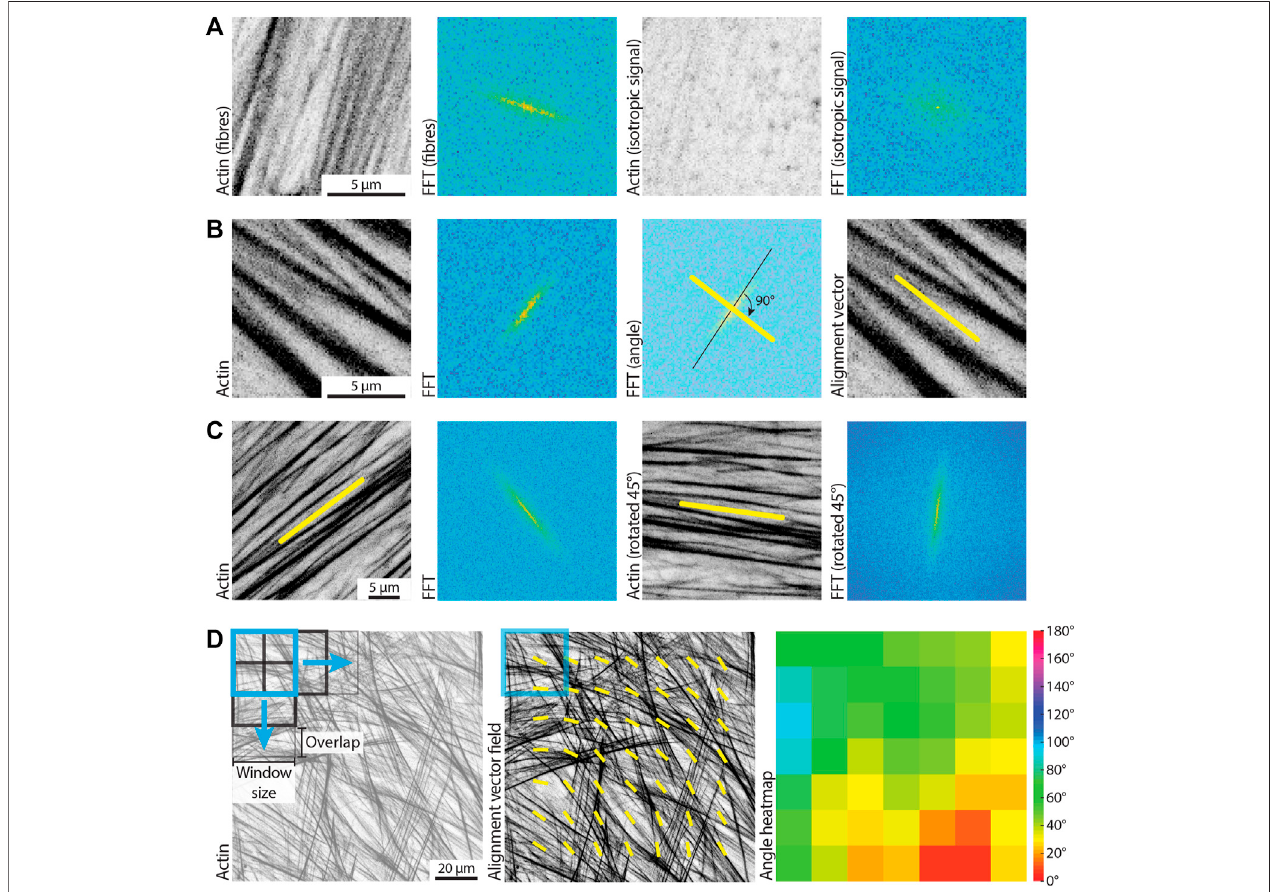
FIGURE 1 | Using FFTs to measure local alignment of biological images. (A) Small windows of a microscopic image are considered, containing either aligned fi lamentous actin fi bers, or isotropic signal. The 2D Fast Fourier Transform (FFT) shows an elongated (i.e., skewed) shape if the image in the real space contains aligned fi brillar features, and displays a more round shape otherwise. Scale bar, 5 μ m . (B) A small window of a microscopic image containing aligned fi lamentous actin fi bers is considered. Its FFT shows a predominantskewness (black line) ofan anglethatis orthogonaltothe direction ofthe fi bersin therealspace image. Theobtained alignmentvector(yellowline) canbeoverlaid totheoriginalimagetohighlightthemeasured fi berorientation.Scalebar,5 μ m . (C) Thealignmentvector is calculated for an image containing aligned actin fi bers by exploiting the characteristics of the FFT. The same image, rotated by 45 ° , is analyzed, to demonstrate robustness of the method to rotation. Scale bar, 5 μ m . (D) A square representing the window size for analysis (250 px , light blue) is overlaid on a fi lamentous actin image. The black squares represent subsequent instances of such a window with the de fi ned overlap, as the image is scanned during the analysis to calculate local alignment vectors (yellow). The heatmap shows a different representation of the alignment vector fi eld, with a wrapped colour scale ranging from 0 ° to 180 ° . Scale bar, 20 μ m .